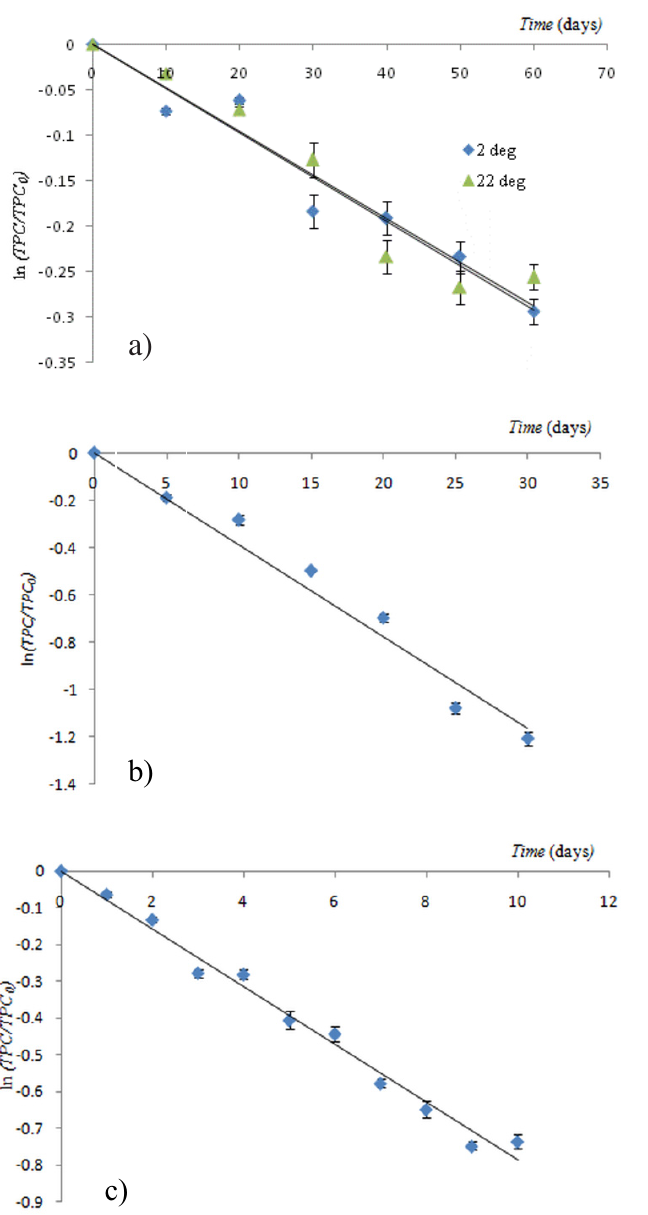
Fig. 1: Degradation kinetics of polyphenols during storage at (a) 2 °C and 22 °C; (b) 55 °C; (c) 75 °C (vertical lines represent SD, n = 3)